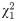
ABC plot of n = 10,000 data points, xi, drawn from the χ12 distribution (see also Fig 3).In addition, APC plots of the identity distribution, x
i = constant (magenta line), and of the uniform distribution in the data range U[min(xi),max(xi)] (green line) are shown. The second main diagonal (dashed line) delivers the points where the yield Y equals the remaining effort described as Y = 1—E. The BreakEven point, i.e., the point on the ABC curve where the profit gain dABC equals 1 which means that the slope of the ABC curve at this point equals a value of 1, is marked a as green star. The limits of sets A, B and C resulting from the present ABC analysis are drawn as red lines.